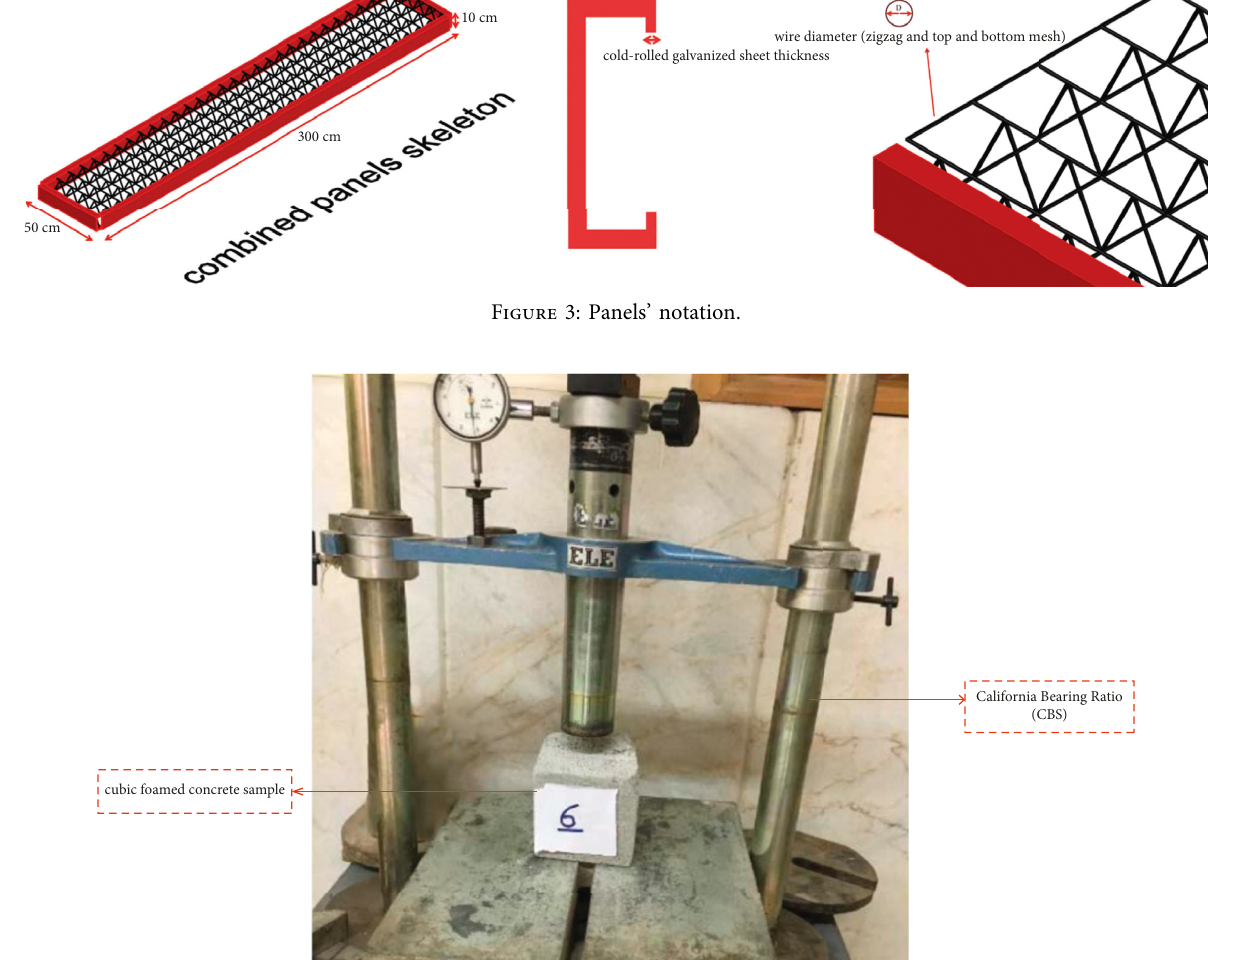
Figure 4: The California bearing ratio (CBR) device.